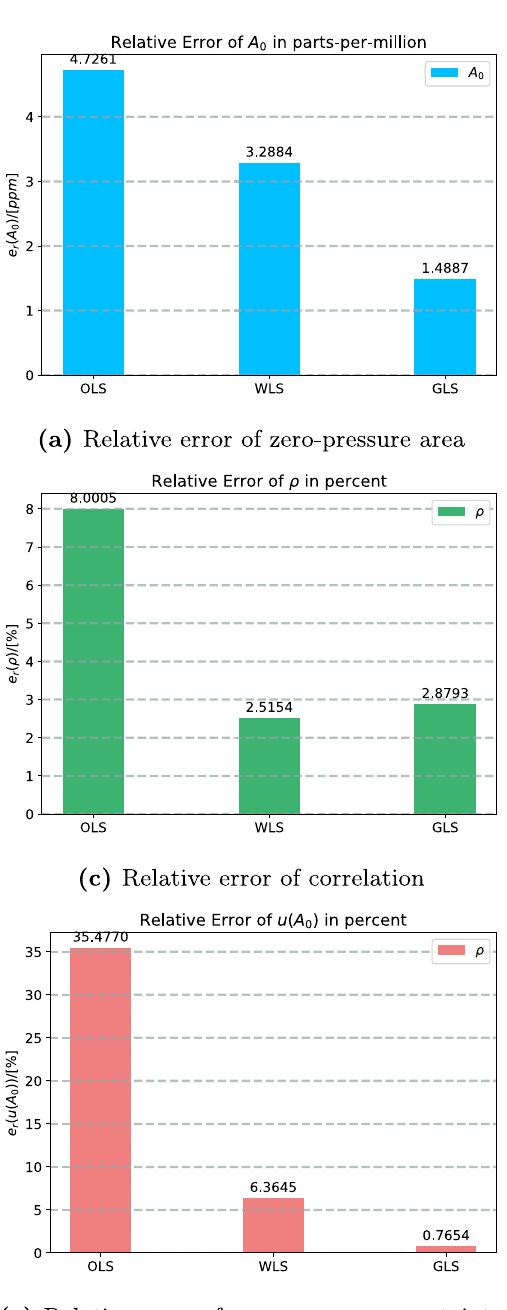
Fig. 5. Comparison of relative errors of the quantities predicted by OLS, WLS and WTLSC regression approaches relative to predictions from a GLS regression approach. These graphs indicate that the relative error between a WTLSC regression and a GLS regression is relatively insigni fi cant, and as a result a pressure metrologist instead of applying a more complicated GLS regression can simply apply a WTLSC regression with the aid of the supplied methodology developed in this